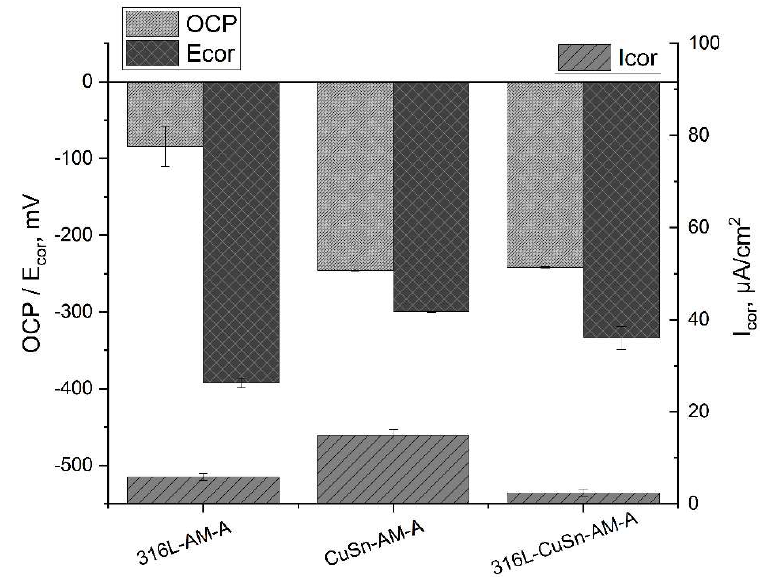
Figure 7. Comparison of the single and multi-materials.